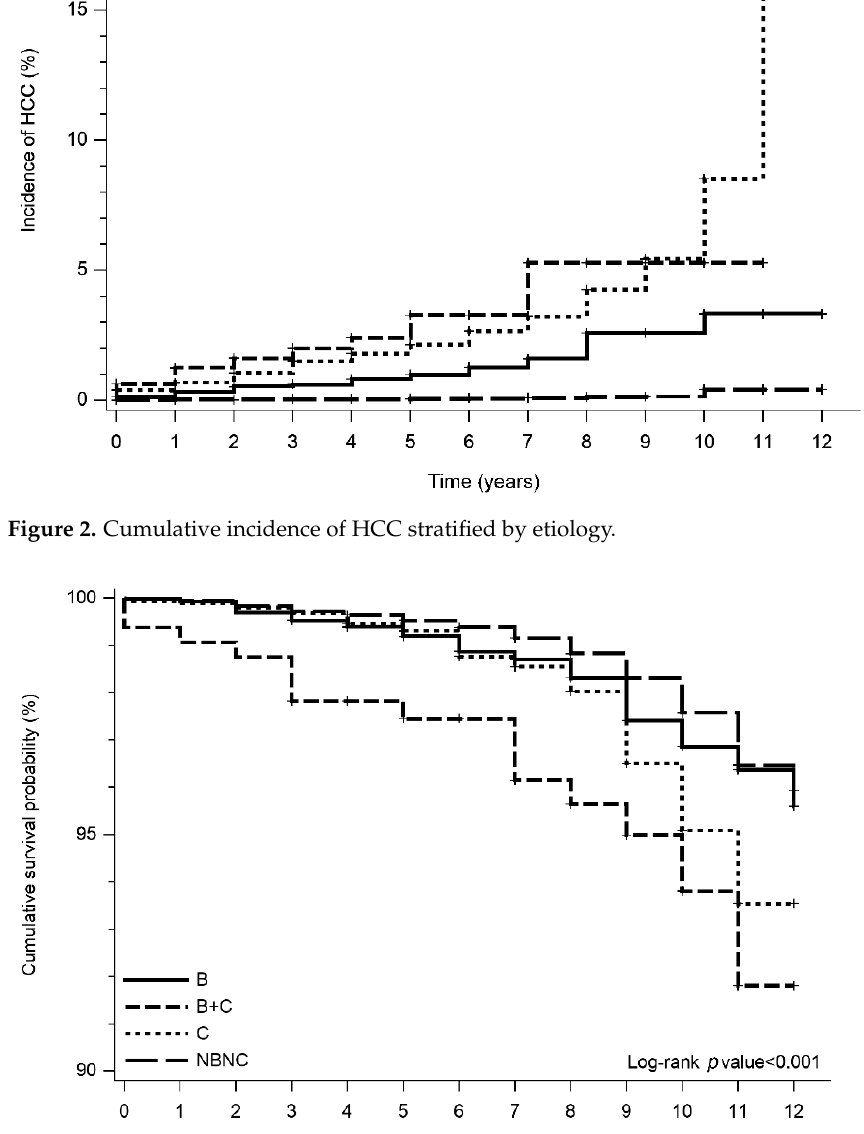
Figure 2. Cumulative incidence of HCC stratified by etiology.